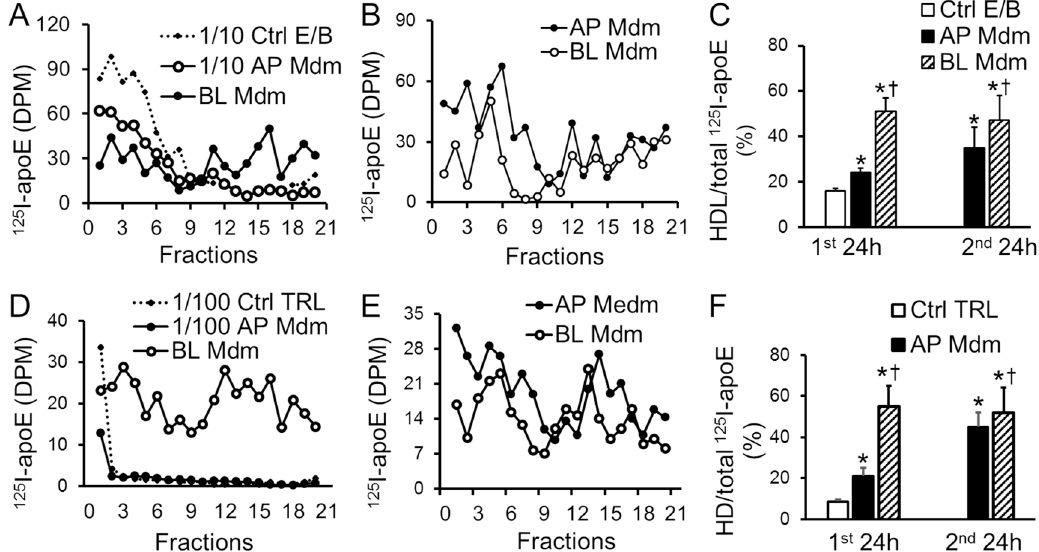
Figure 5. Transendothelial transport of apoB-LPs resulted in apoE redistribution among lipoprotein fractions. The AP side of the MAEC monolayer was incubated with 125 I-apoE E/B-LPs (E/B) ( A – C ) or TRLs ( D – F ); the BL side was treated with medium alone for 24 h (1st 24 h). ( B , E ): The MAEC monolayer, treated as above, was washed with heparin solution ( B ), or low ionic strength solution ( E ), and followed by incubation with fresh medium for another 24 h (2nd 24 h). The AP and BL media collected from the 1st 24 h and the 2nd 24 h incubations, as well as the cell-untreated Ctrl 125 I-apoE E/B-LPs and TRLs, were subjected to DG ultracentrifugation. Twenty fractions were collected for determination of radioactivity. ( C , F ): The % of the HD fraction 125 I-apoE in the total 125 I-apoE of the AP and BL media, and the Ctrl E/B-LPs and TRLs (HD/total 125 I-apoE) was calculated using the following equation: (The radioactivity in fractions 10–20/the radioactivity in fractions 1–20) × 100. Values represent the mean ± SE of three experiments; * p < 0.05 vs. the cell-untreated Ctrl E/B-LPs or TRLs, and † p < 0.05 vs. AP medium.